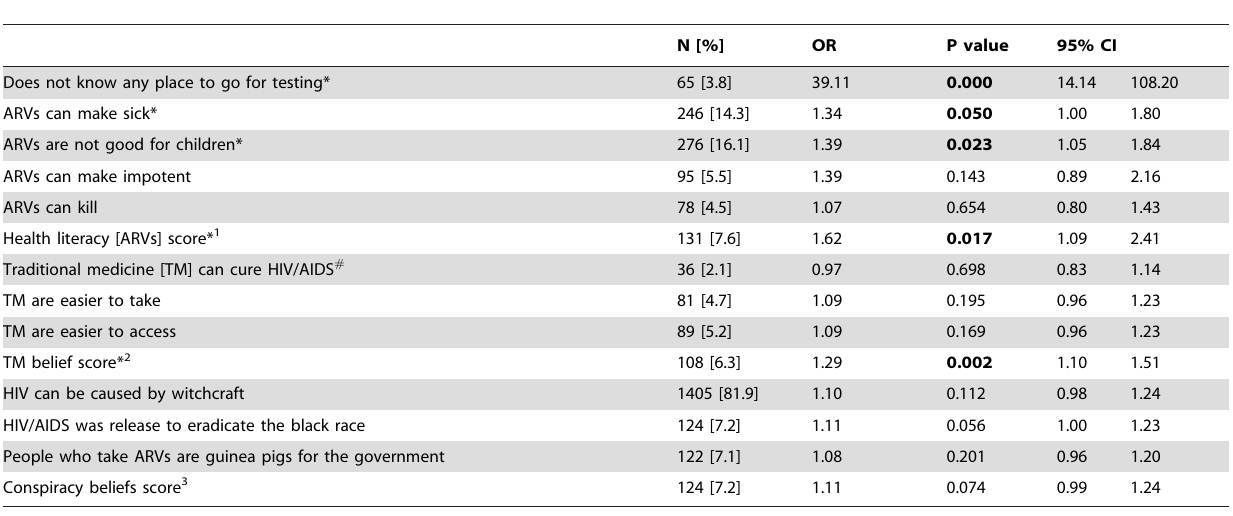
Table 5. Crude odds ratios beliefs about HIV and